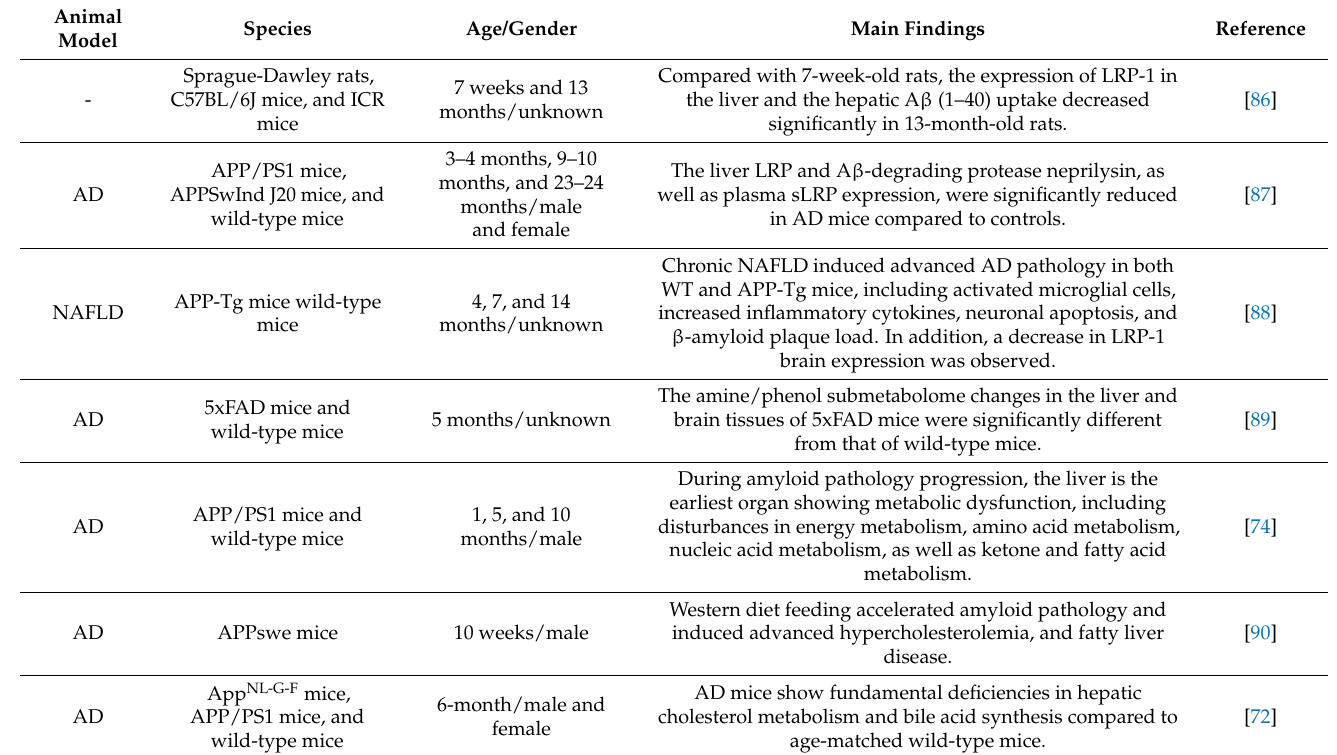
Table 1. Animal studies on the crosstalk between liver dysfunction and AD